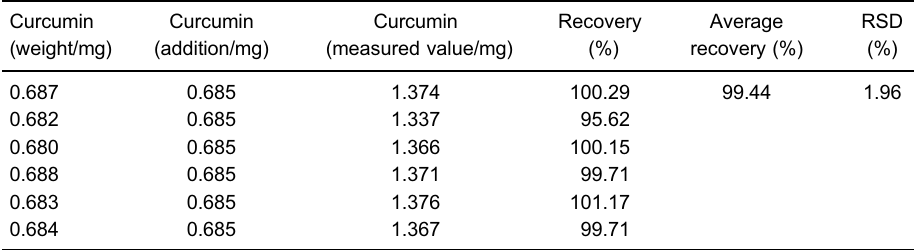
Table 4. Curcumin sample recovery rate test results.